Question: Does the figure show an increasing or a decreasing trend?
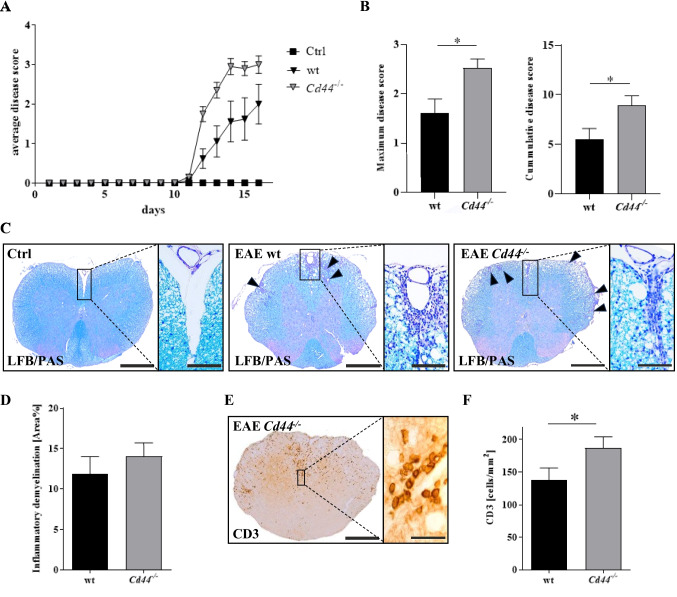
Answer: increasing